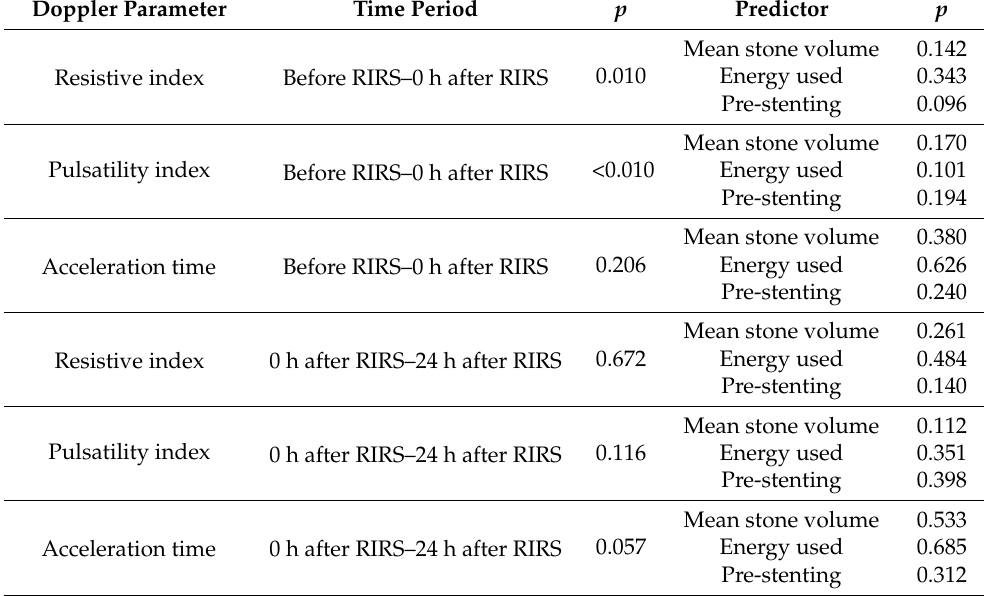
Table 4. A summary of the results of the multivariate analysis including probability